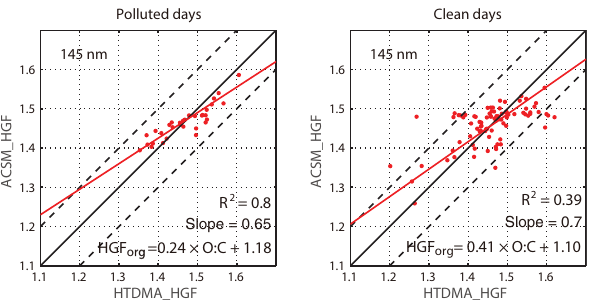
1.1 1.2 1.3 1.4 1.5